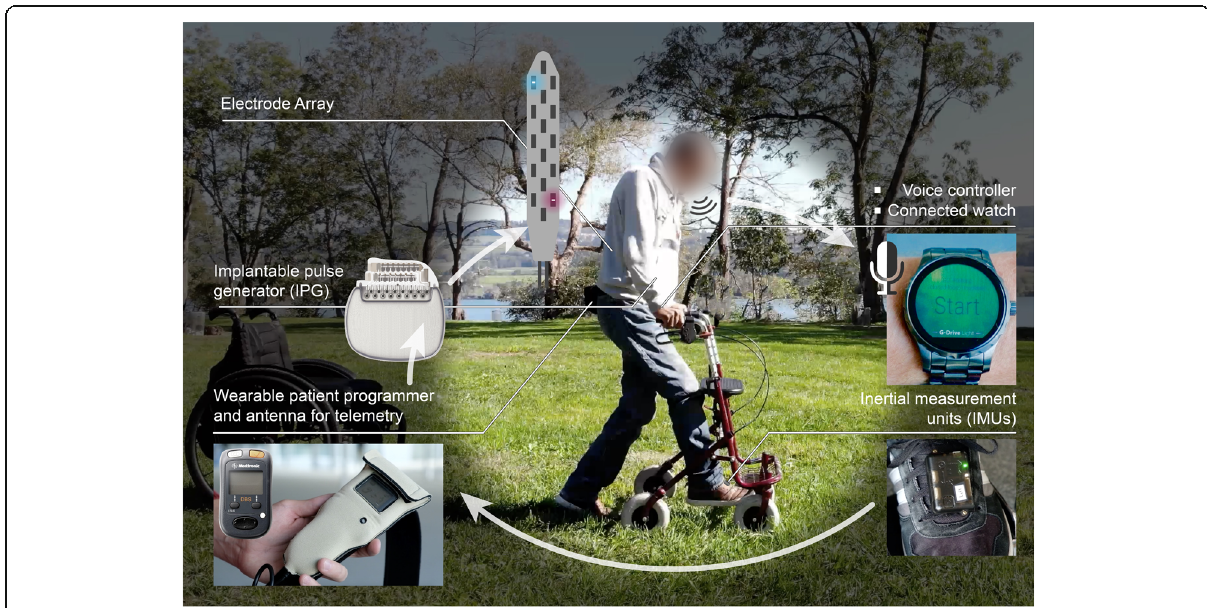
Fig. 5 Ecological principles should guide the development of bioelectronic technology for SCI. Making the technology useable in the patient ’ s natural setting is paramount to its utility. This photograph illustrates the technological framework that enables real-time control of EES outside the laboratory environment. Developing technology based on these ecological principles will require the input and collaborative effort of multiple specialties including neurosurgeons, neurologists, rehabilitation specialists, physiotherapists, engineers, and scientists in order to